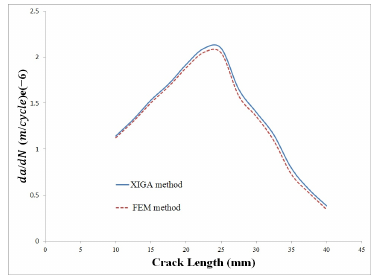
Figure 12. Fatigue life variation at different crack